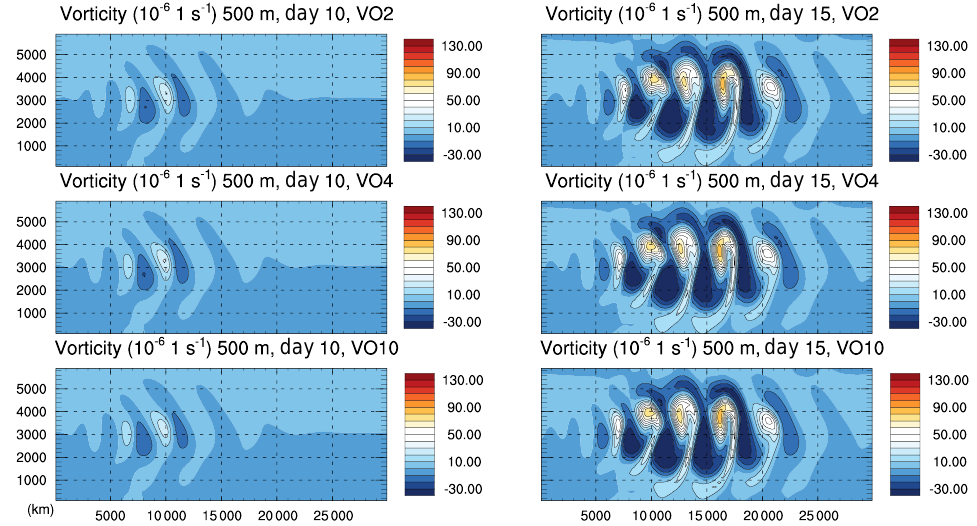
Figure 4. Baroclinic wave in a Cartesian channel at vertical orders 2, 4, and 10. Vorticity at 500m on days 10 and 15 at the resolution (cid:49)x = 200km, (cid:49)y = 200km, (cid:49)z = 1 . 5km. Contour interval: 1 . 0 × 10 − 5 s − 1